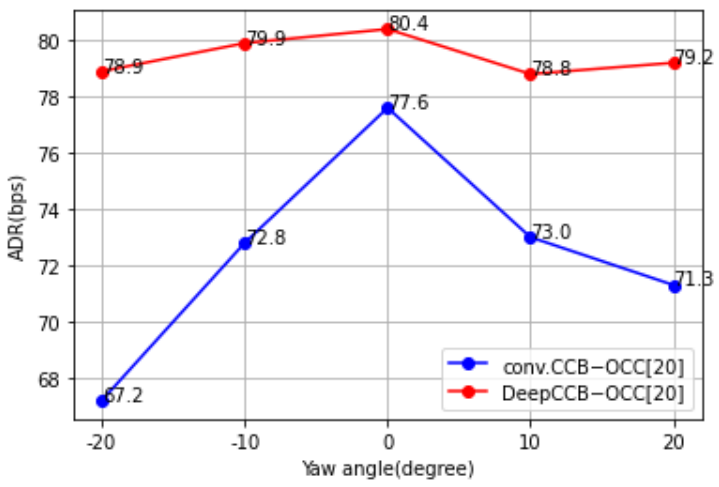
Figure 13. Achievable data rate performance according to yaw angle between the display and the camera. Data adapted from [20]. 2020 Sung-Yoon Jung et al.